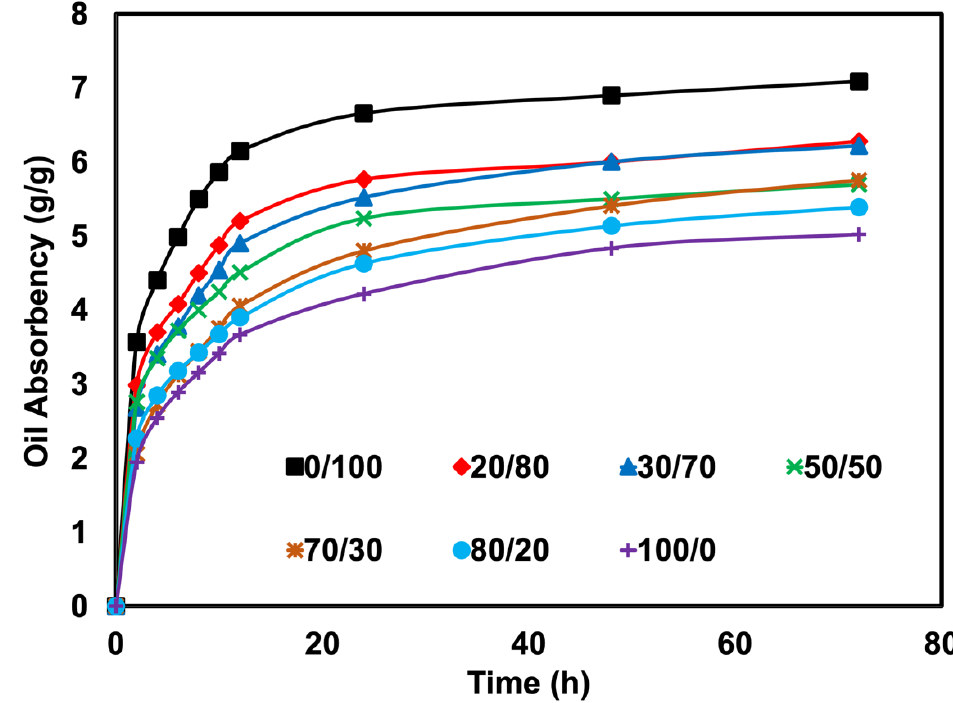
Figure 5. Oil absorbency as a function of contact time of SR/NR blends.